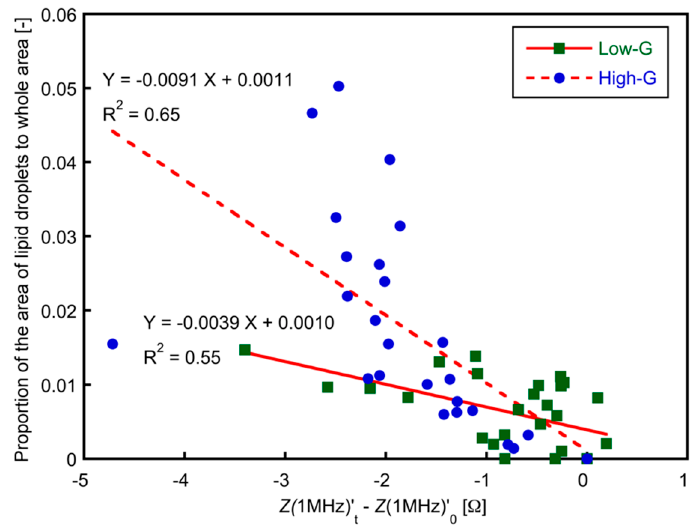
Figure 9. The relationship between Z(1 MHz)’ t − Z(1 MHz)’ 0 and the proportion of area of lipid droplets to entire area. The entire data in low-G and high-G groups are plotted. A significant negative correlation was found (R 2 = 0.49, p < 0.05).